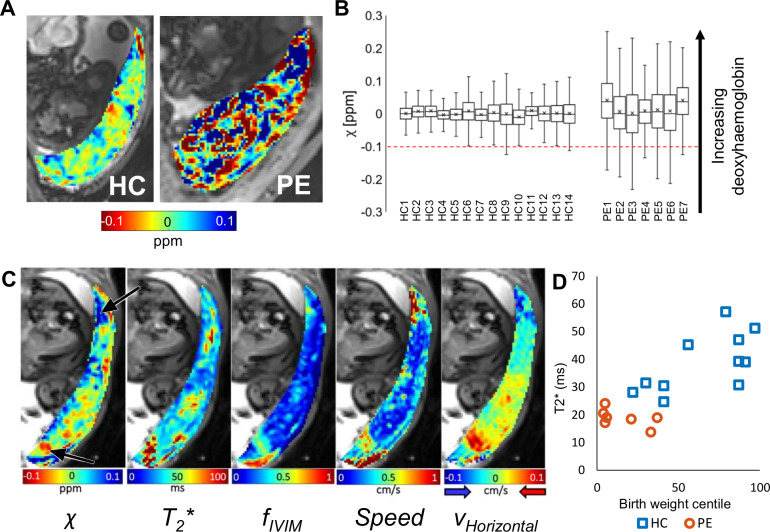
Magnetic susceptibility of the placenta.(A) Maps of magnetic susceptibility (χ) of the placenta (blue corresponds to deoxygenated blood) for HC3 (moved slightly since the acquisition in Fig 2A) and PE6. (B) Plot of the median (−), mean (+), interquartile range (box), and absolute range of susceptibilities (χ) for the HCs and PEs. The red dotted line indicates the value expected for fully oxygenated blood. The χ of the PE placentas is significantly higher (P = 0.010). (C) Maps of χ, T2*, fIVIM, net speed, and horizontal velocity for HC8. The lower arrow indicates oxygenated blood flowing into the placenta, and the upper arrow indicates deoxygenated blood flowing out of the placenta (which was also associated with a reduced T2*). (D) Variation of T2* with birth weight centile. Underlying data plotted in panels B and D are provided in S1 Data. fIVIM, intravoxel incoherent motion fraction; HC, healthy control pregnancy; PE, preeclamptic pregnancy.